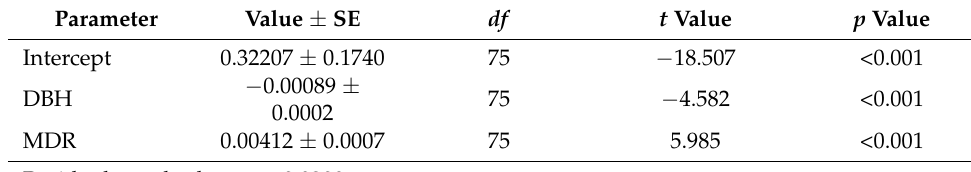
Table 8. Parameter estimates of the best candidate by model 3, Table 7.